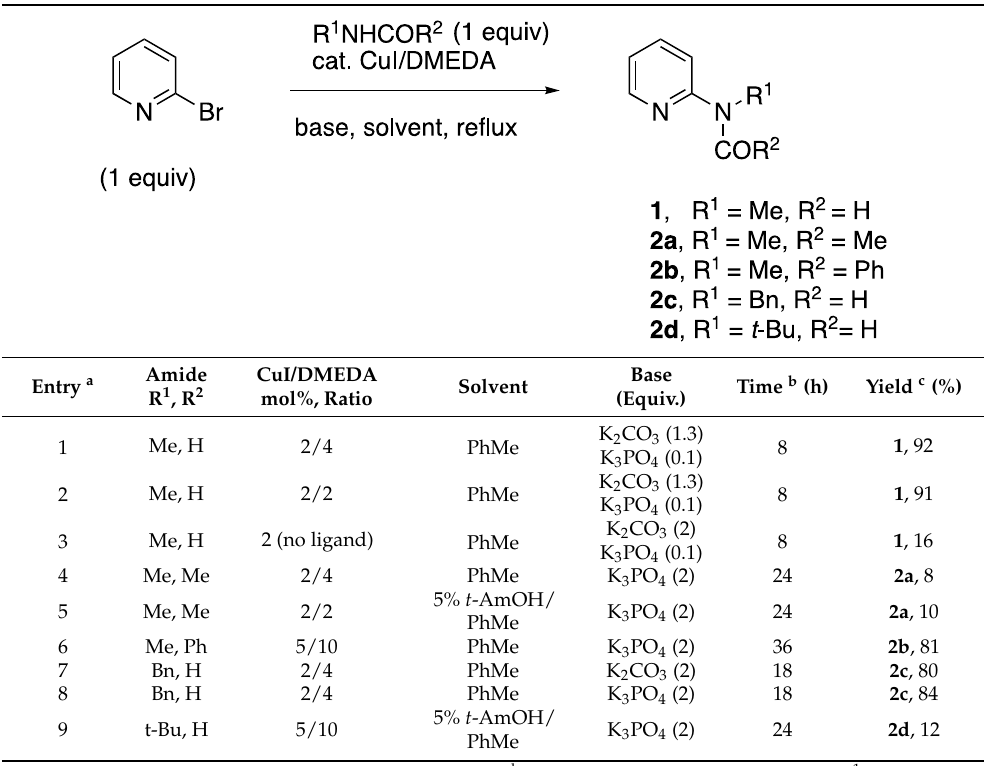
Molecules 2022 , 27 , x FOR PEER REVIEW 6 of 10